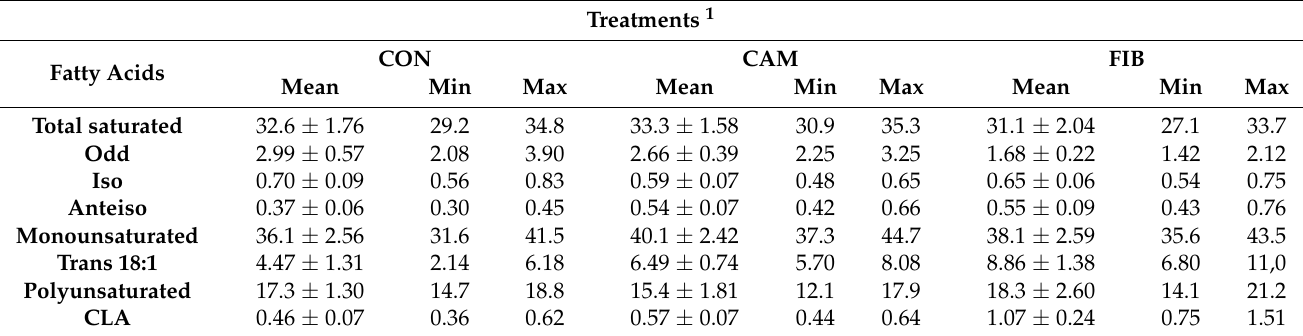
Table 1. Minimum (Min), maximum (Max) and average contents (mean ± standard deviation, g per 100 g of total fat) of several fatty acid groups in Longissimus muscle from lambs fed the experimental